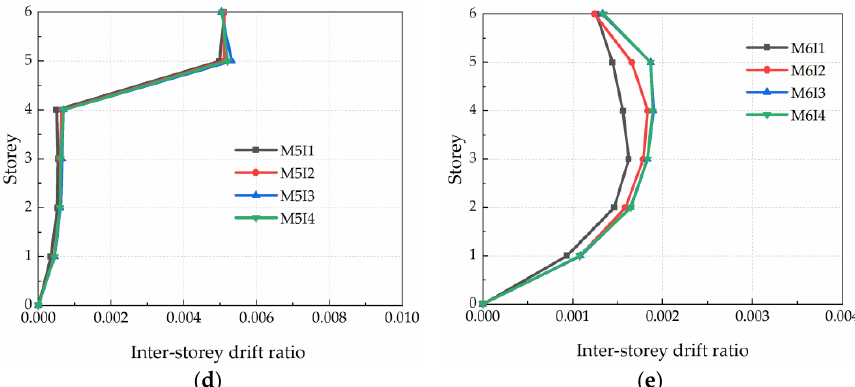
Figure 13. The interstorey drift ratio of different models under taft ground motion: ( a ) M2; ( b ) M3; ( c ) M4; ( d ) M5; ( e ) M6.